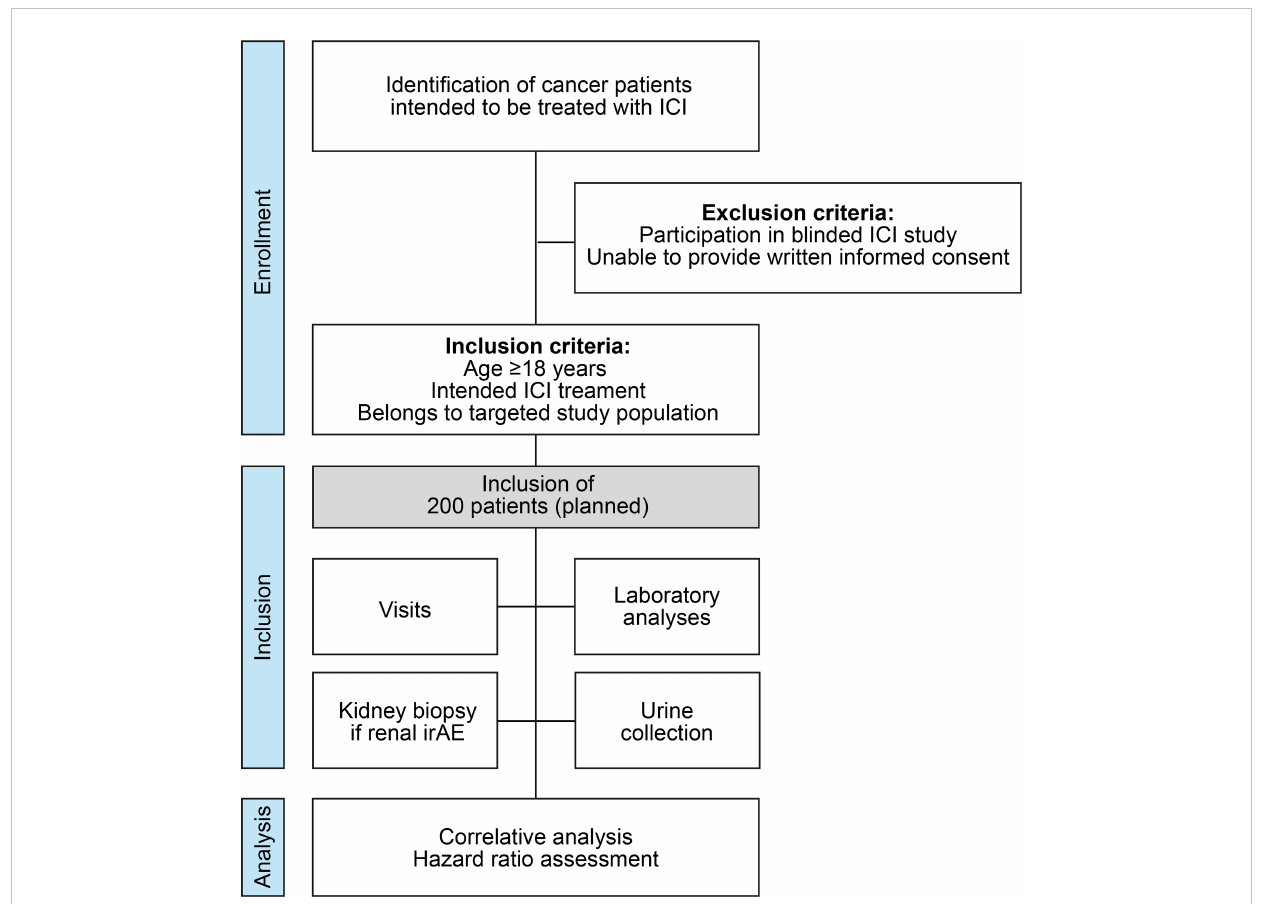
FIGURE 1 STROBE fl ow chart of the study protocol. ICI, immune checkpoint inhibitor; irAE, immune-related adverse event; STROBE, strengthening the reporting of observational studies in